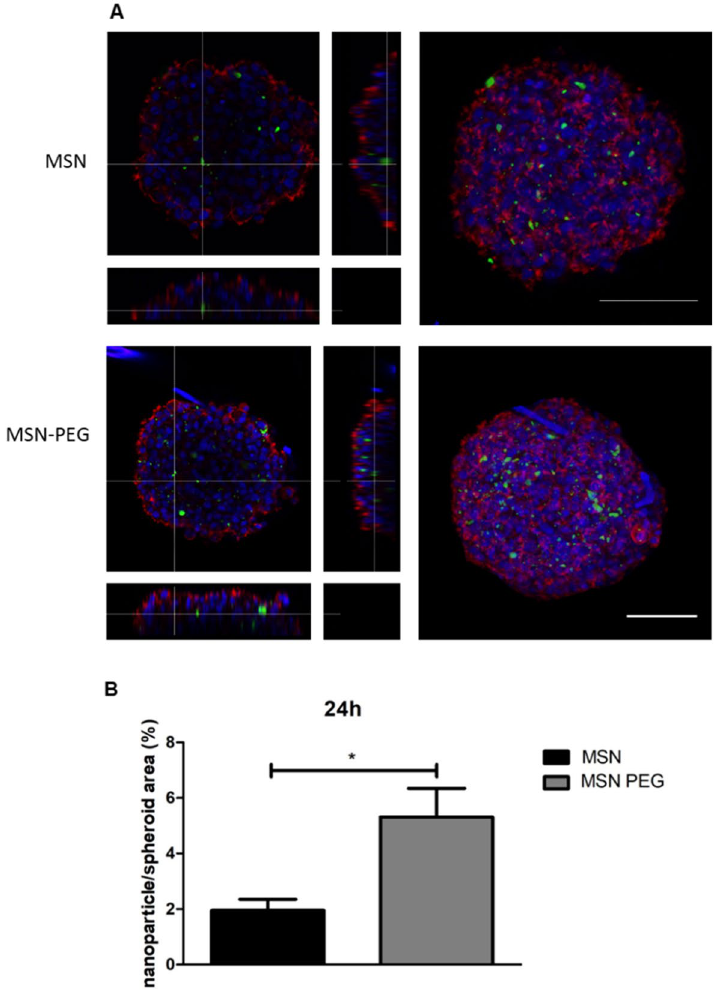
Figure 11. MSN-FITC and MSN-FITC-PEG penetration into U-87 GBM spheroids. ( A ) Left: orthogonal images are the combination of 10 z-stacks of 5 µm each (50 µm from the bottom to the core of the spheroid). Right: combination of all z-stacks (up to 23 stacks). Quantification of nanoparticle (FITC) area on the combined image stacks in relation to the spheroid total area after 24 h. Results are mean ± SEM of three different images. *p <